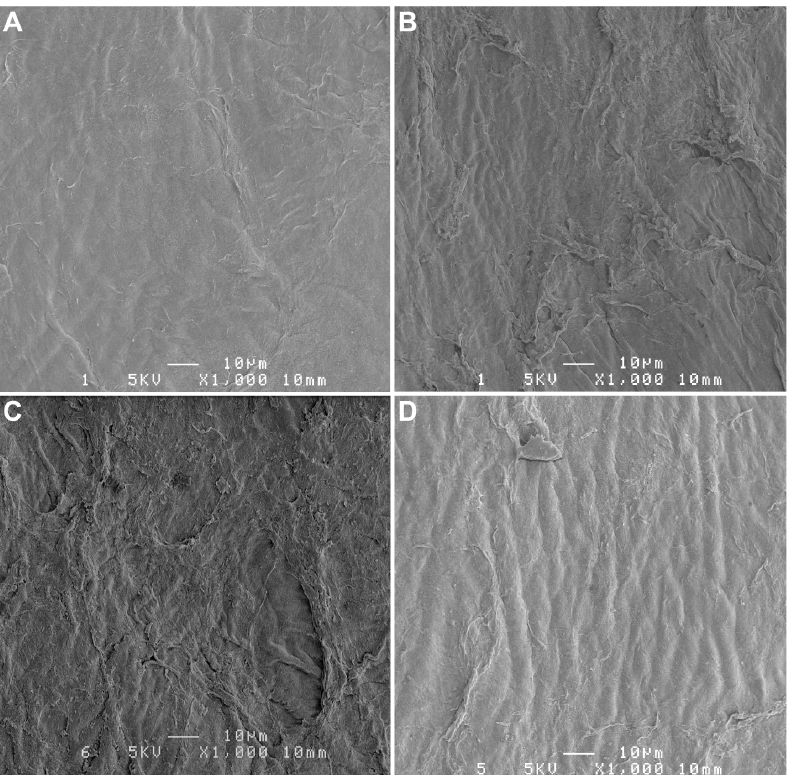
Figure 4. Representative scanning electron microscopy images of the post-ablation stromal surface for various levels of preoperative corneal hydration. CCT=598 m m (A); CCT=801 m m (B); CCT=996 m m (C); and CCT=1104 m m (D). These images illustrate the difficulty of quantifying corneal surface roughness based on human eye perception. The cornea illustrated in (A) had a preoperative thickness within the normal range and was used as a reference.